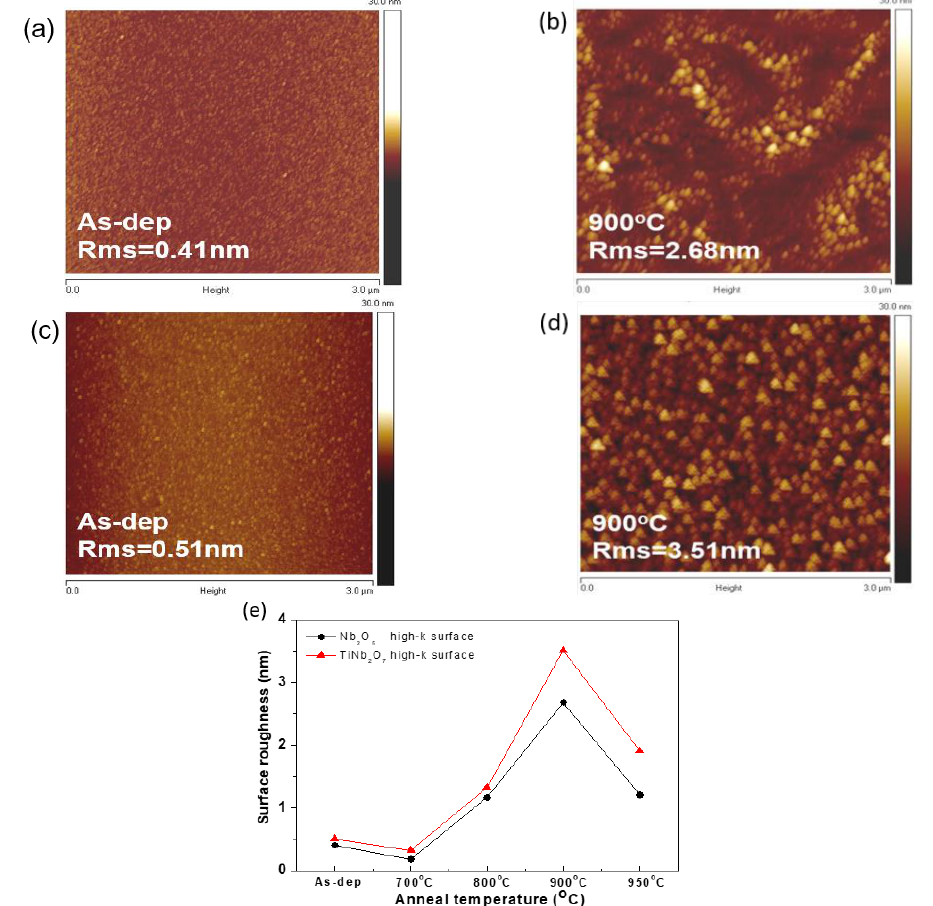
Figure 6. AFM images of the ( a ) as-deposited and ( b ) 900 °C annealed Nb 2 O 5 films; AFM images of the ( c ) as-deposited and ( d ) 900 °C annealed TiNb 2 O 7 films; ( e ) surface roughness of Nb 2 O 5 and ( c ) as-deposited and ( d ) 900 ◦ C annealed TiNb 2 O 7 films; ( e ) surface roughness of Nb 2 O 5 and TiNb 2 O 7 TiNb 2 O 7 films as a function of annealing temperature. films as a function of annealing